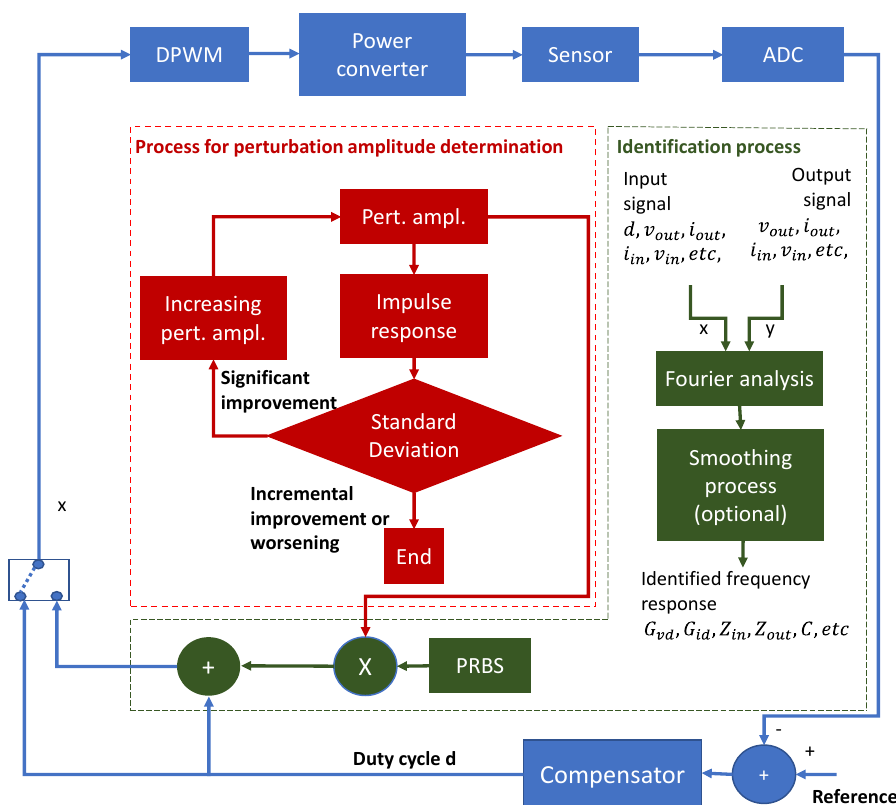
Figure 5. Complete block diagram of the proposed identification system for open-loop identification.